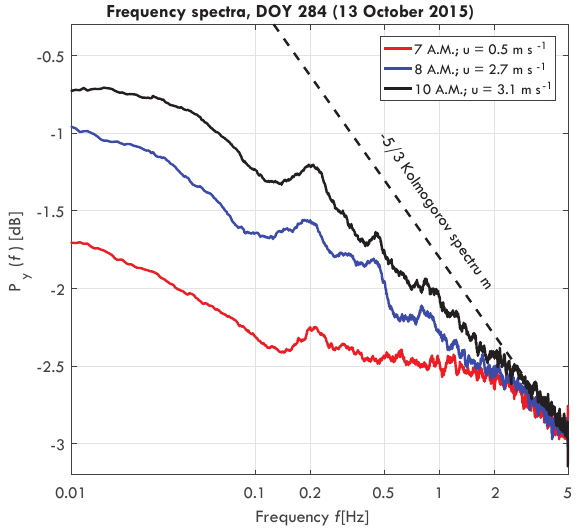
Figure 2. Frequency spectra of a Goupia glabra tree for different wind speeds on day of year (DOY) 284 (11 October 2015), includ- ing turbulent wind spectrum (dashed black), taken from van Em- merik et al.